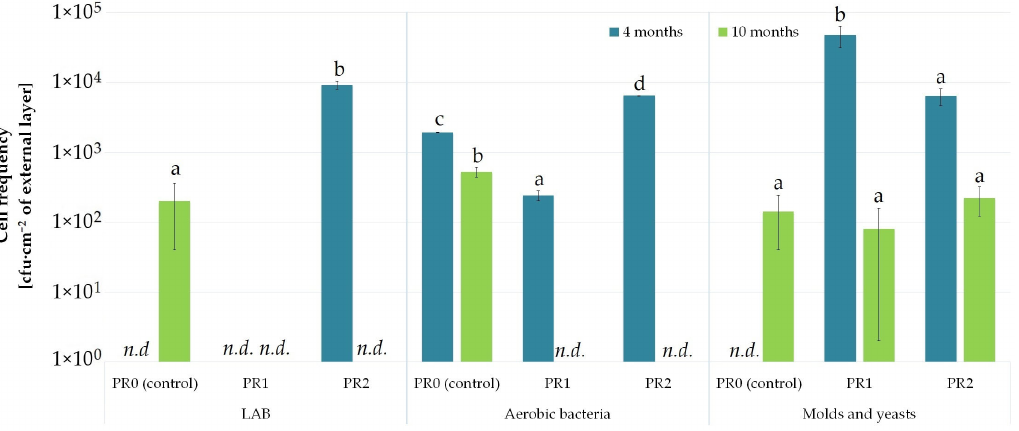
Figure 9. Microbial colonization of outer film surfaces during the second experimental stage. Storage time:4 and 10 months. Bars marked with the same letters indicate no statistical difference ( p < 0.05); results were analyzed separately for each group of microorganisms; n.d.— not detectable. Table 3. Dry mass content and pH changes in silage during storage for 4 (t1) and 10 (t2) months. Values marked with the same letters indicate no statistical difference ( p <